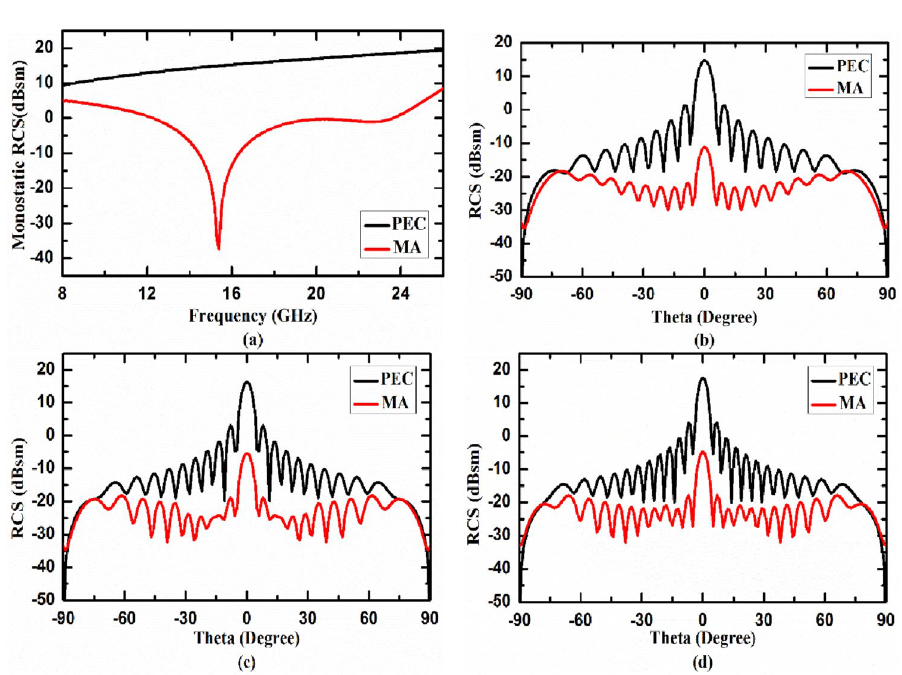
Figure 6. ( a ) Simulated monostatic RCS of the proposed planar MA and PEC under normal incidence, bistatic RCS of PEC and MA at ( b ) 14.84 GHz, ( c ) 17.99 GHz, ( d ) 21.14 GHz under normal